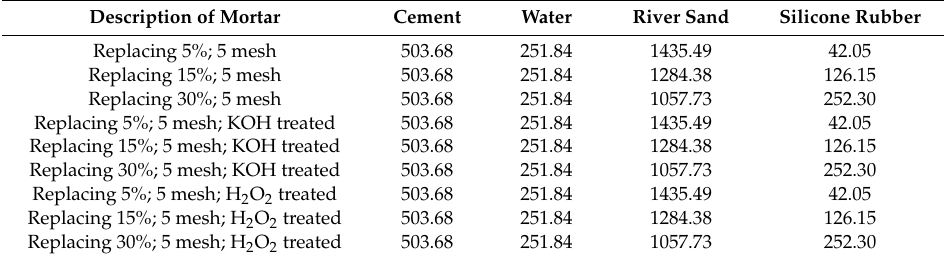
Table 3. The detailed mix proportions of mortar in the second stage test (kg / m 3